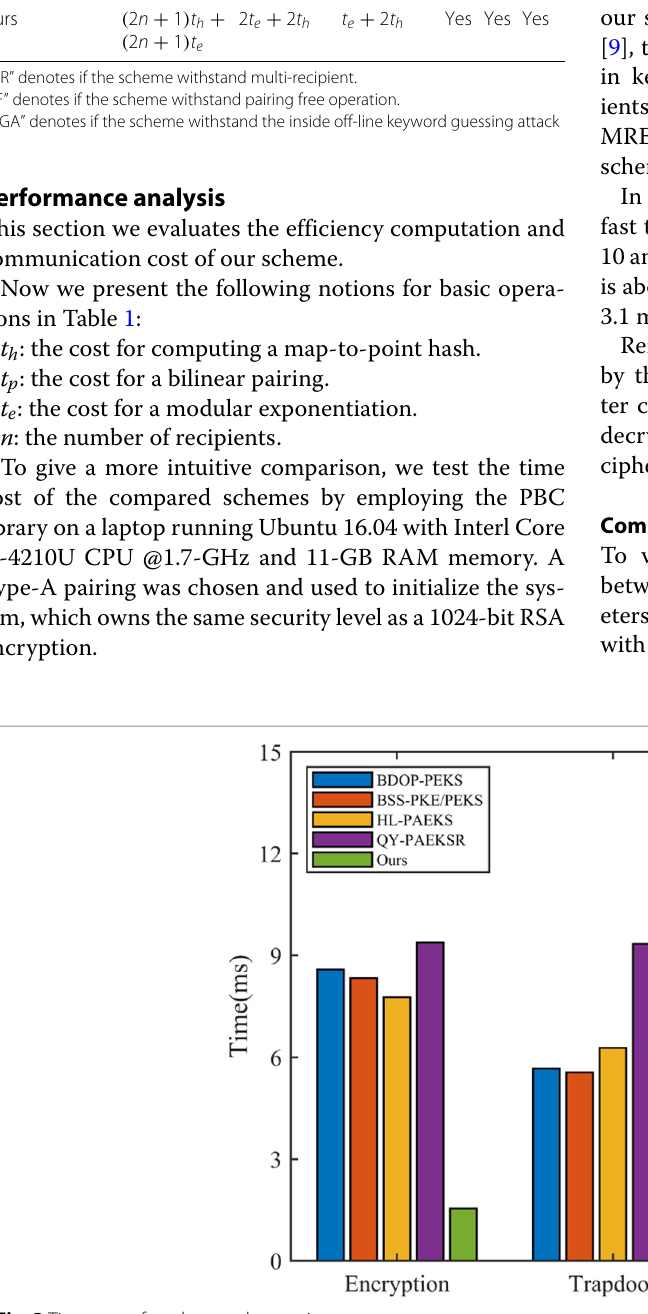
Fig. 3 Time cost of ten keyword